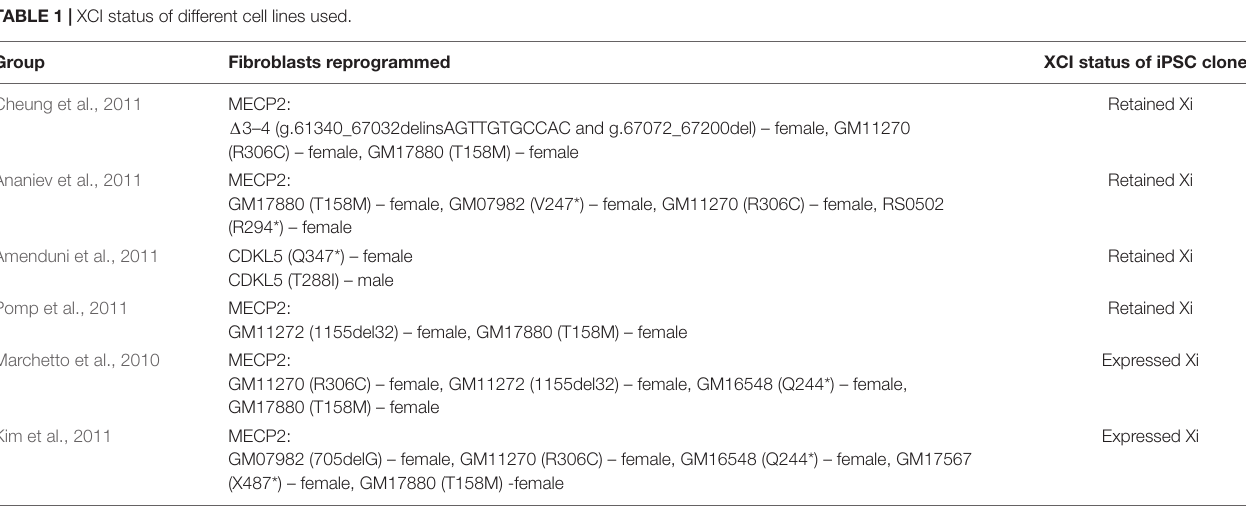
TABLE 1 | XCI status of different cell lines